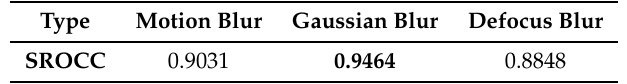
Table 3. SROCC of three blur distortion types tested on LIVE II dataset. The best SROCC score is marked in boldface.